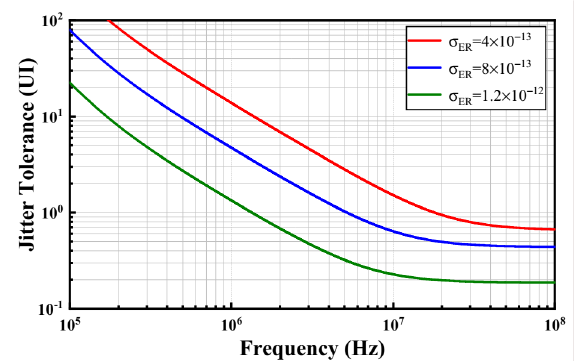
Figure 9. Jitter tolerance of different input